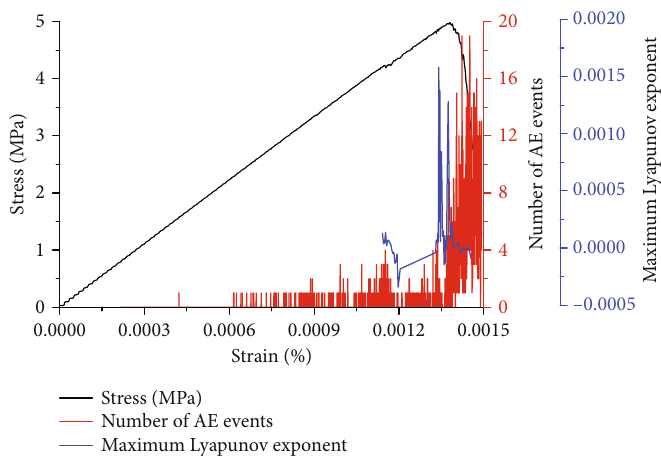
Figure 3: Coal-rock stress-strain-number of AE events-maximum Lyapunov exponential variation diagram. Table 2: Summary of mechanical parameters of coal-rock standard specimens.